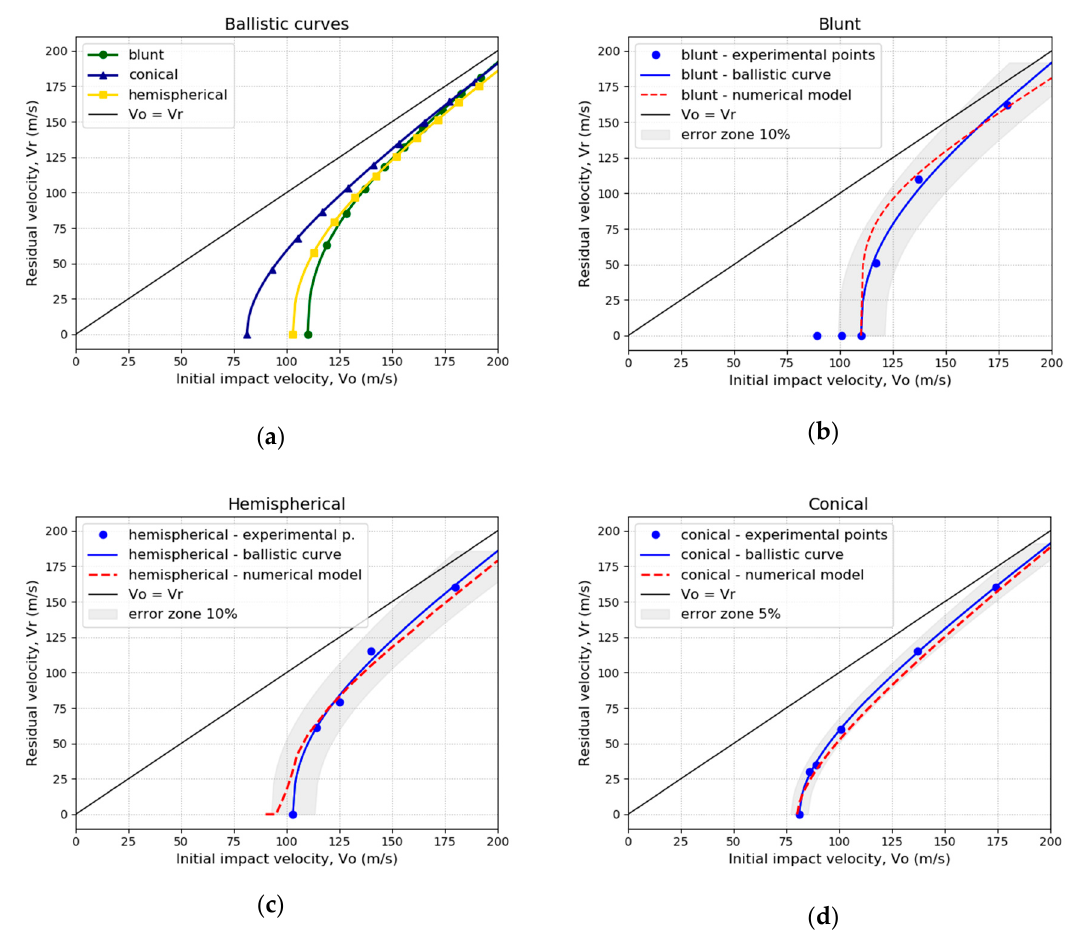
Figure 14. Ballistic curves: ( a ) experimental curves; ( b ) blunt projectile; ( c ) hemispherical projectile; ( d ) conical projectile.